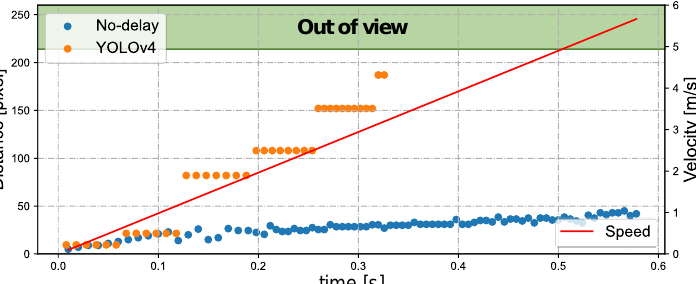
Figure 15. Relationship between velocity and distance from the detection ROI to the image center during free-fall bottle tracking.